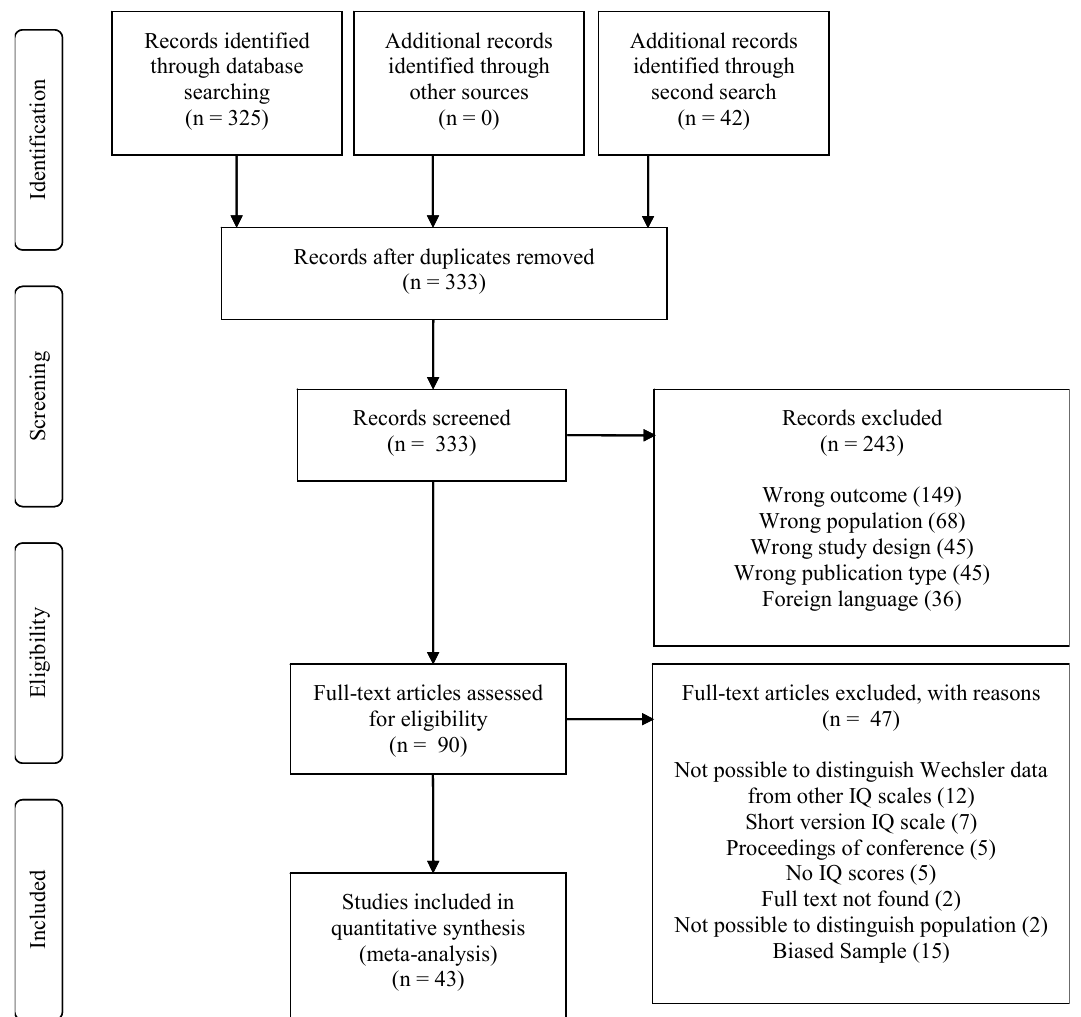
Figure 1. Flowchart of the selected articles.